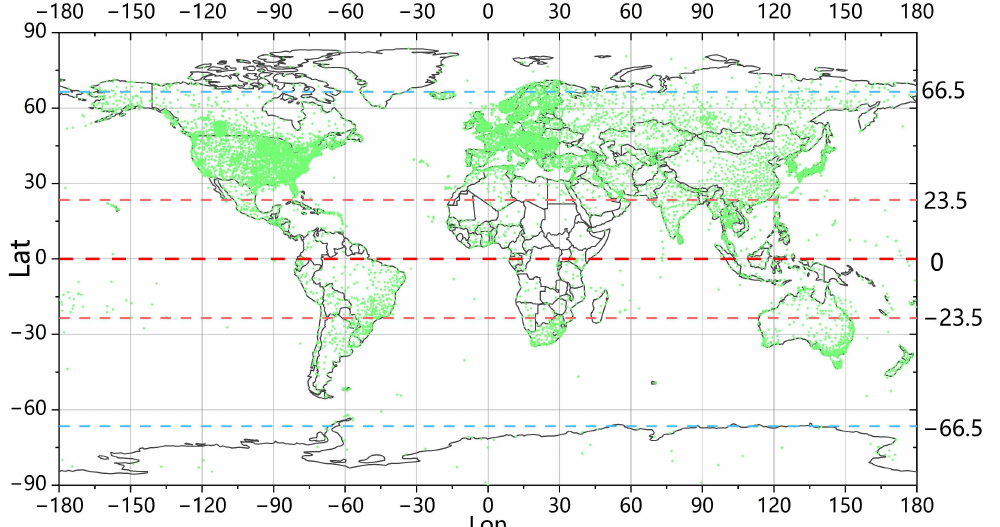
Figure 2. Global distribution of meteorological stations. The green dots represent meteorological stations. The denser the green dots, the more weather stations there are in the